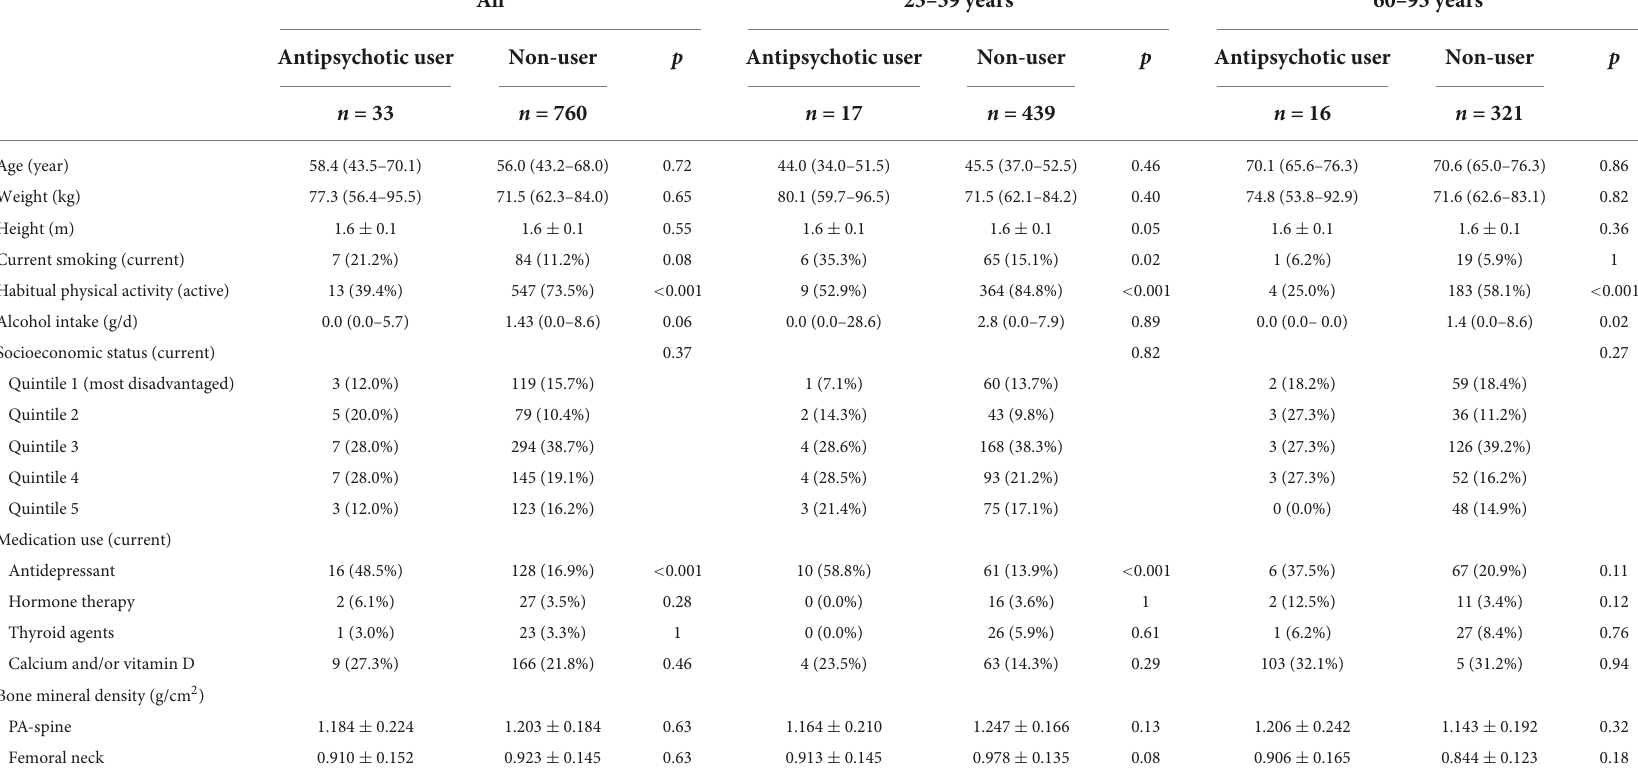
TABLE 1 Characteristics of antipsychotic users and non-users according to age for